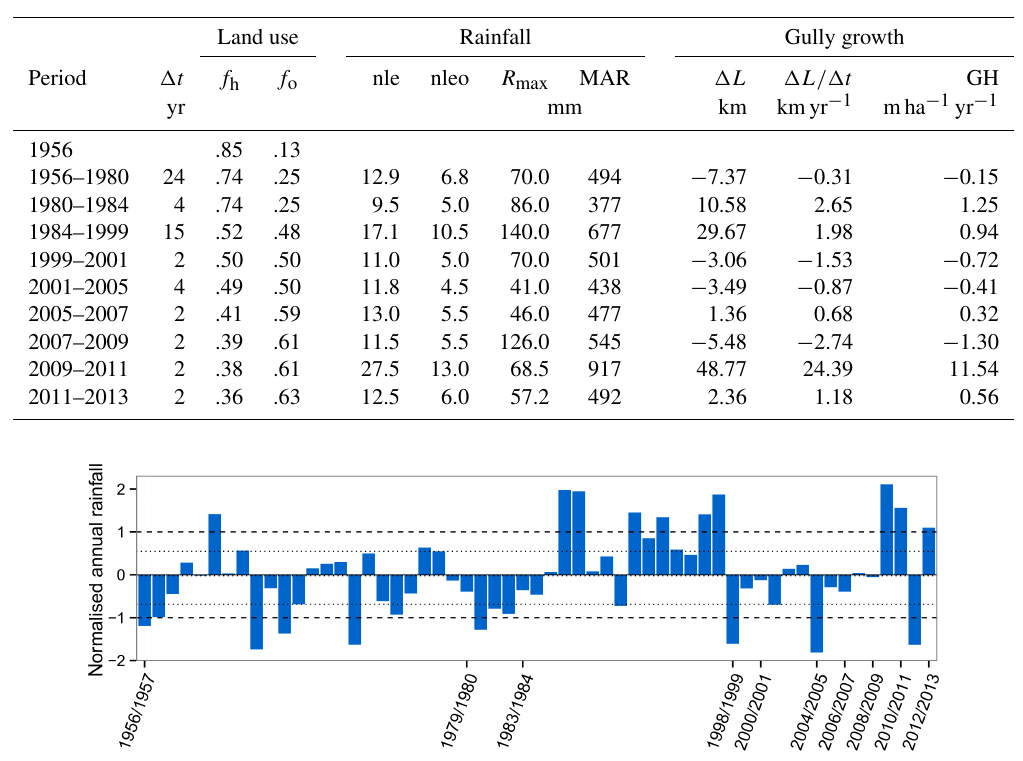
Table 3. Land use, rainfall indicators, and gully growth. f h and f o : fractions of surface dedicated to herbaceous and olive crops, in the first year of each period. nle: number of 24h rainfall events per year higher than 13mm; nleo: number of 24h rainfall events per year over the average 24h rainfall plus the standard deviation; R max : highest daily rain depth registered within the period; MAR: mean annual rainfall in